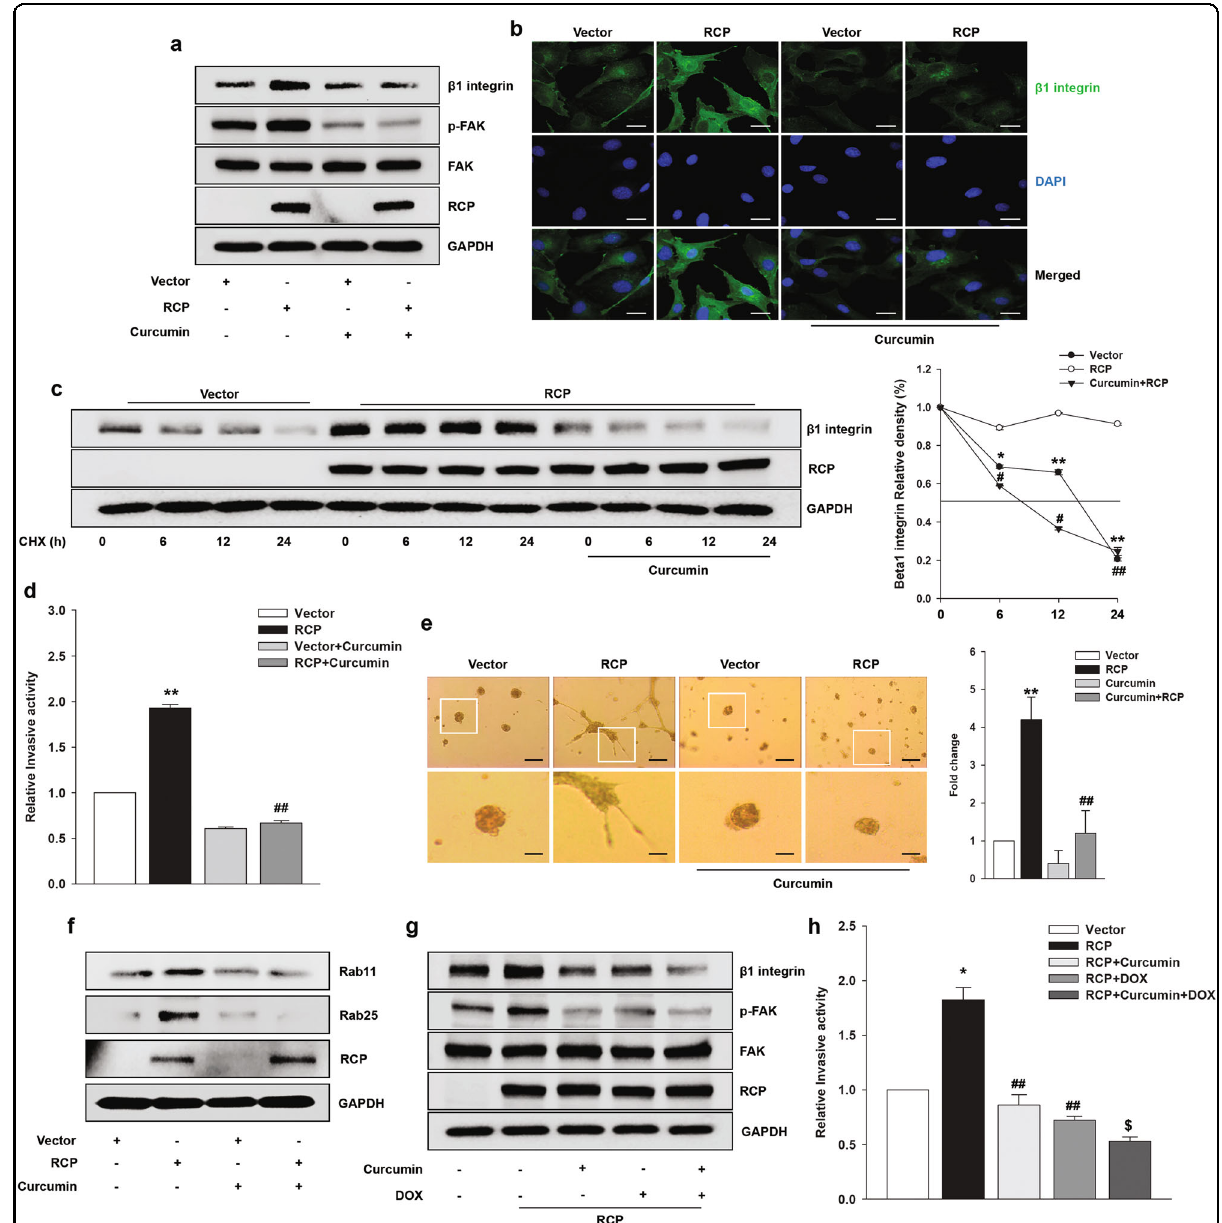
Fig. 5 Curcumin inhibits stabilization of β 1 integrin protein and FAK phosphorylation. a SKOV-3 cells were transfected the indicated vectors for 48 h, serum-starved, and treated with curcumin (20 μ M) for 2 h. Immunoblotting. b The expression of β 1 integrin was visualized by immuno fl uorescence. Original magni fi cation, ×400; scale bar, 20 μ m. c SKOV-3 cells were transfected with the indicated vectors for 48 h, serum- starved, and pretreated with curcumin (20 μ M) for 2 h and then incubated with CHX (20 μ g/ml) for the indicated times. Immunoblotting (left). Densitometric analysis (right; mean ± s.d. * P < 0.05, ** P < 0.01 vs. the control vector, # P < 0.05, ## P < 0.01 vs. RCP overexpression only). d SKOV-3 cells were transfected with the indicated vectors for 48 h followed by treatment with curcumin (20 μ M) for 1 h. Invasion assay (mean± s.d. ** P < 0.01 vs. the control vector, ## P < 0.01 vs. RCP overexpression only). e Phase contrast images showing the morphology of stably transfected SKOV-3 cells with the indicated vectors followed by treatment with curcumin (20 μ M) for 4 days on Matrigel. Original magni fi cation, ×100; scale bar, 200 μ m. Inset shows higher magni fi cation (left). The number of branches was counted and quanti fi ed (right); mean ± s.d. ** P < 0.01 vs. the control vector, ## P < 0.01 vs. RCP overexpression only. f SKOV-3 cells were transfected with the indicated vectors for 48 h, serum-starved, and treated with curcumin (20 μ M) for 1 h. Immunoblotting. g SKOV-3 cells were transfected with the indicated vectors for 48 h, serum-starved, and treated with curcumin (20 μ M), DOX (0.001 μ M), and curcumin with DOX. Immunoblotting and h invasion assay (mean± s.d. * P < 0.05 vs. the control vector, ## P < 0.01 vs. RCP overexpression only, $ P < 0.05 vs. RCP overexpression and DOX treatment). All experiments were repeated three